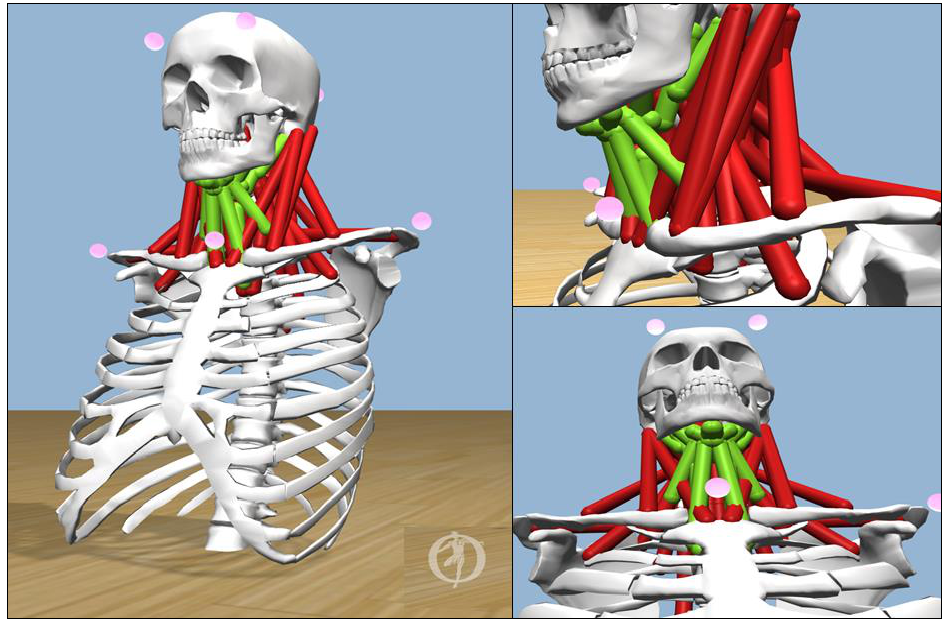
Figure 3. Hyoid muscles (in green color).